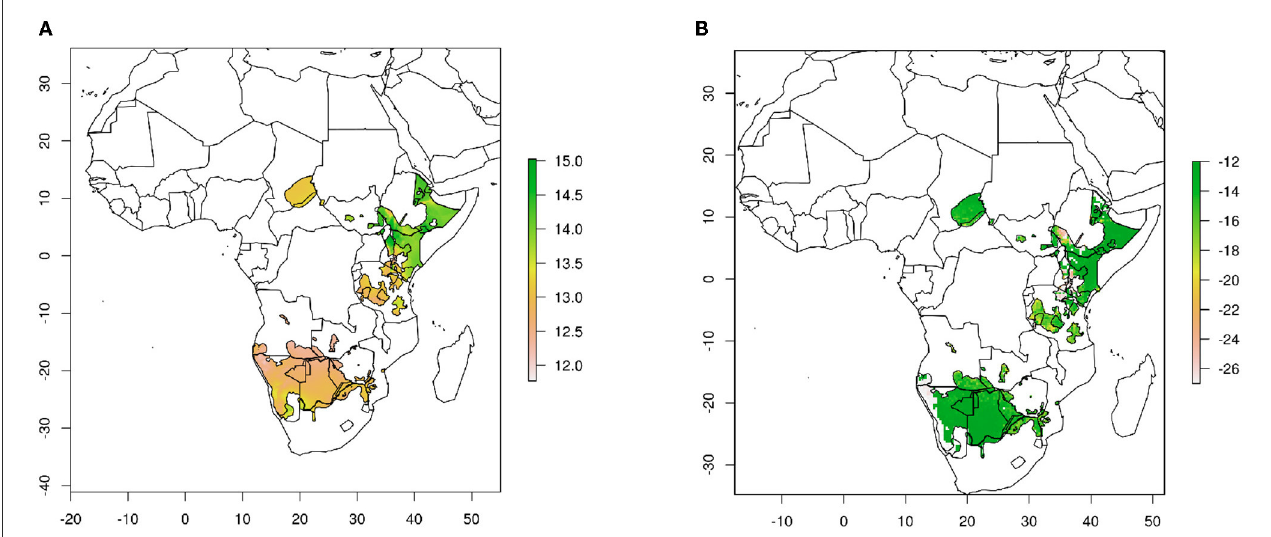
FIGURE1 Cheetah hair isoscapes used in this study. (A) δ 18 Ovalues. (B) δ 13 Cvalues. Base maps produced from data of Terzer et al. (2013) and Terzer-Wassmuth et al. (2021) for δ 18 Oand Still and Powell (2010) for δ 13 C.